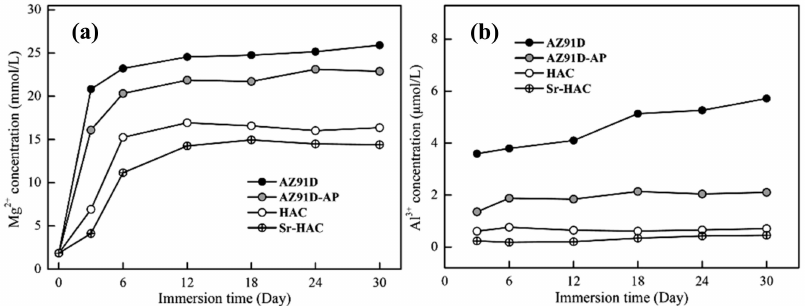
Figure 10. In vitro ion release profiles of ( a ) Mg 2 + and ( b ) Al 3 + ion concentration of the SBF immersed with AZ91D, AZ91D-AP, HAC and Sr-HAC specimens for the immersion duration of 30 days.